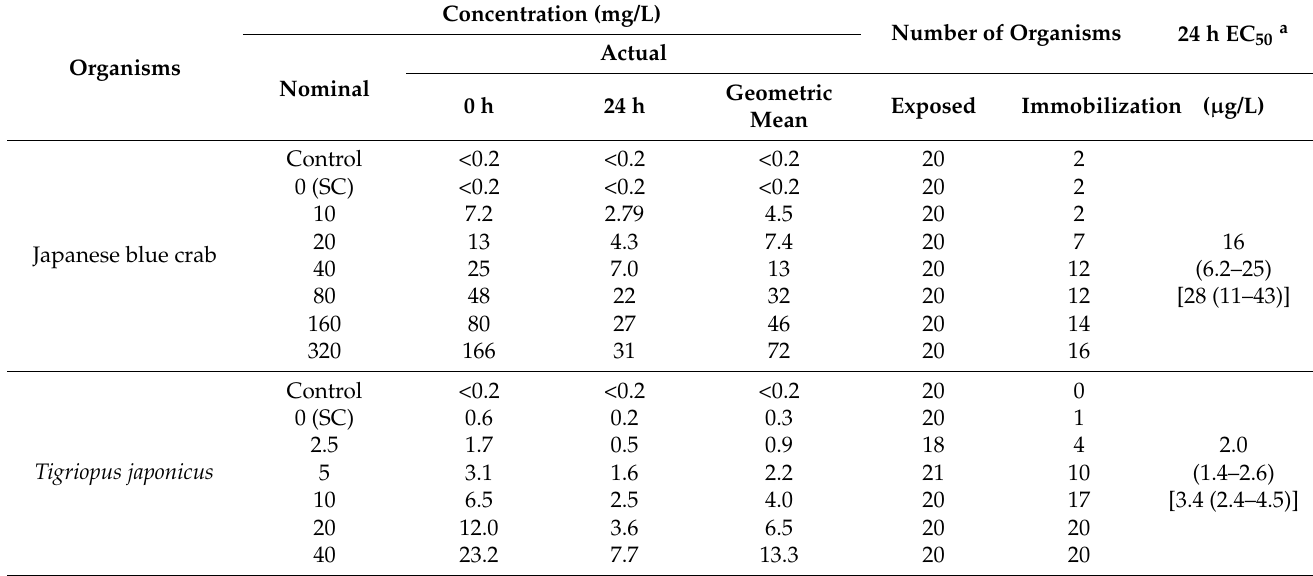
Table 2. Acute toxicities of polycarbamate (PC) to zoeae (<24 h post hatching) of Japanese blue crab ( Portunus trituberculatus ) and nauplii (<24 h post hatching) of Tigriopus japonicus